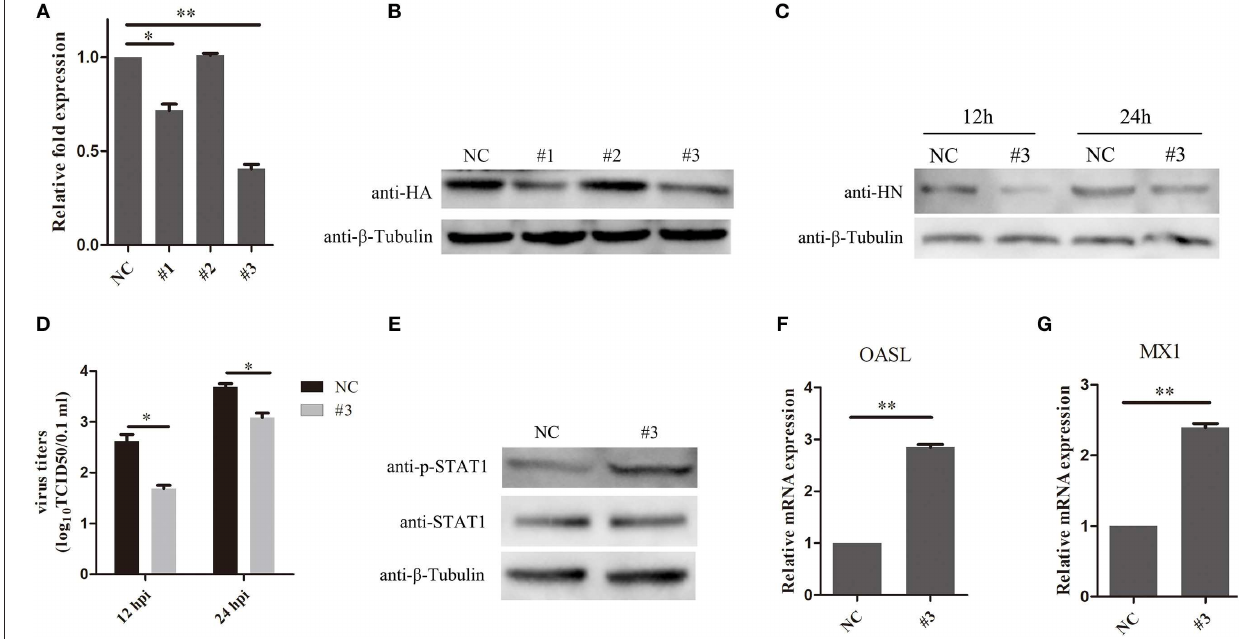
FIGURE 5 | Knock-down of SOCS3 inhibits NDV replication. (A,B) CEF cells were co-transfected with a pCMV-SOCS3-HA expression plasmid and non-targeting control siRNA (NC) or SOCS3-targeting siRNAs, followed by qRT-PCR and WB using an anti-HA antibody to compare the efficiencies of these three siRNAs. (C,D) CEF cells were transfected with NC or #3. CEF cells were infected NDV (0.1 MOI) 24h post transfection, and cells and supernatant were harvested at 12 and 24 hpi. WB was performed to detect the expression of HN protein of NDV (C) . TCID50 was used to measure viral RNA replication (D) . (E) WB was performed to detect the expression of STAT1 and phosphorylated STAT1 in SOCS3-knockdown cells at 24 hpi. (F,G) qRT-PCR was used to detect the expression of MX1 and OASL. Data presented are from three independent experiments and presented as mean ± SD. * P < 0.5, ** P <